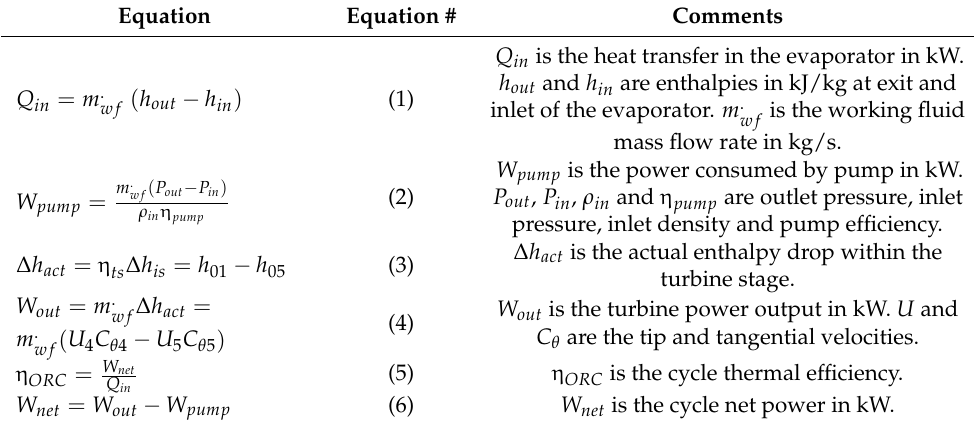
Table 2. Basic equations for turbine and ORC applied in the current study. Equation Equation #